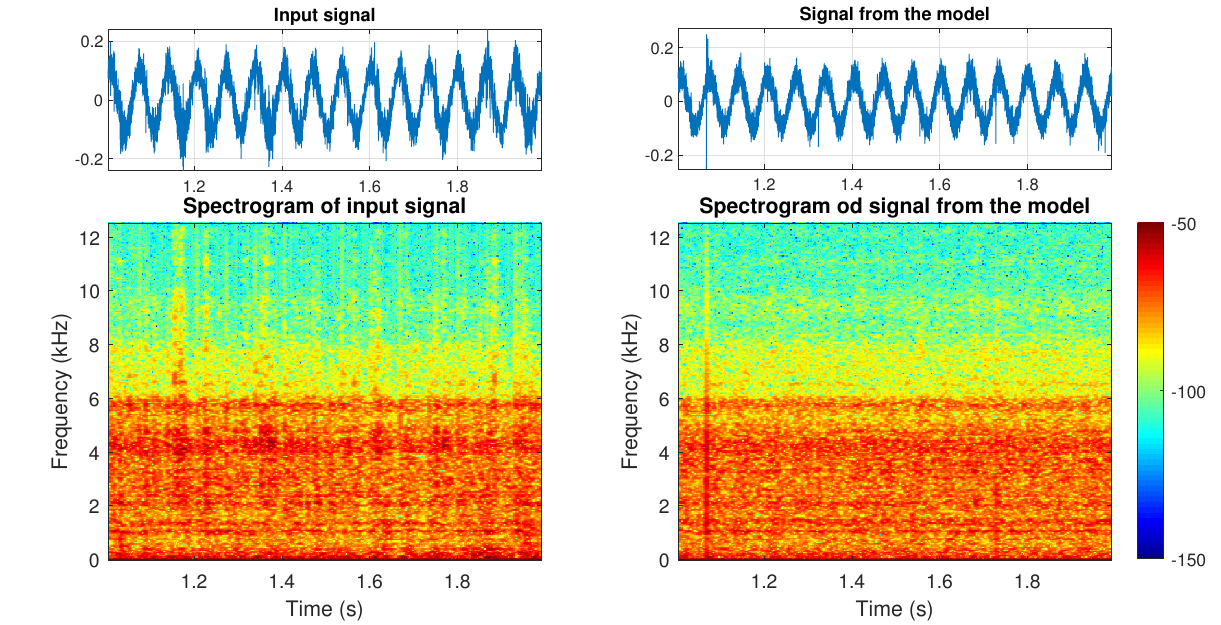
Figure 16. The one second of the time series and spectrogram of input signal ( left ) and signal from the model ( right